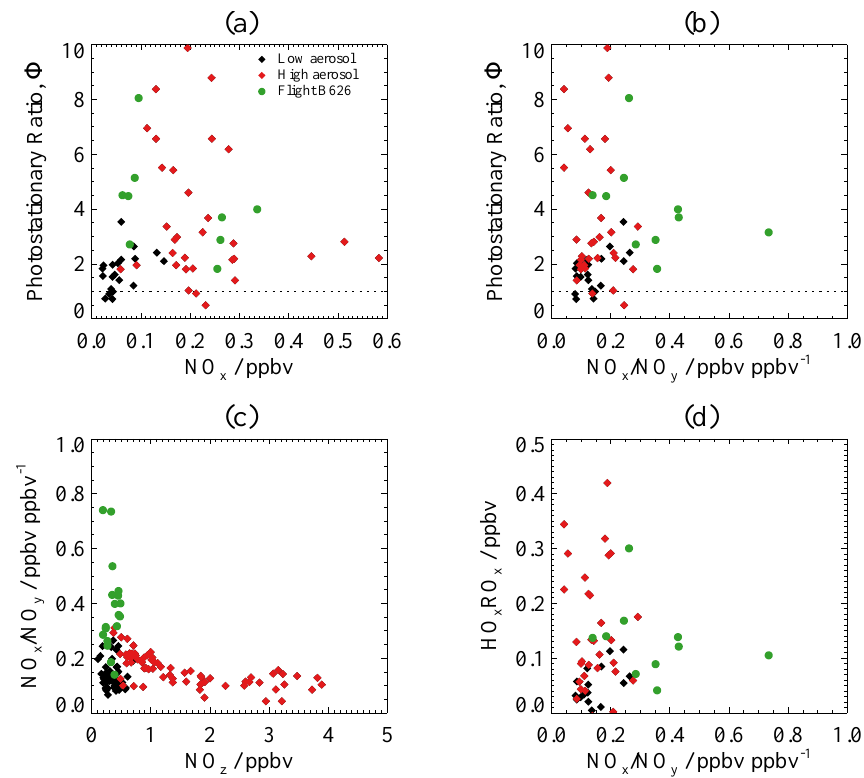
Fig. 12. Relationship between O 3 photostationary state and the NO y budget measured in boreal biomass burning plumes over the course of the BORTAS campaign. (a) and (b) show the calculated photostationary ratio, 8 , versus NO x mixing ratios (ppbv) and the ratio of NO x to NO y respectively. (c) shows the relationship between NO x /NO y and NO z . (d) shows calculated total peroxy radical mixing ratios, HO x RO x , required for a photostationary ratio of unity versus NO x mixing ratio. Symbols are the same as those described for Fig.